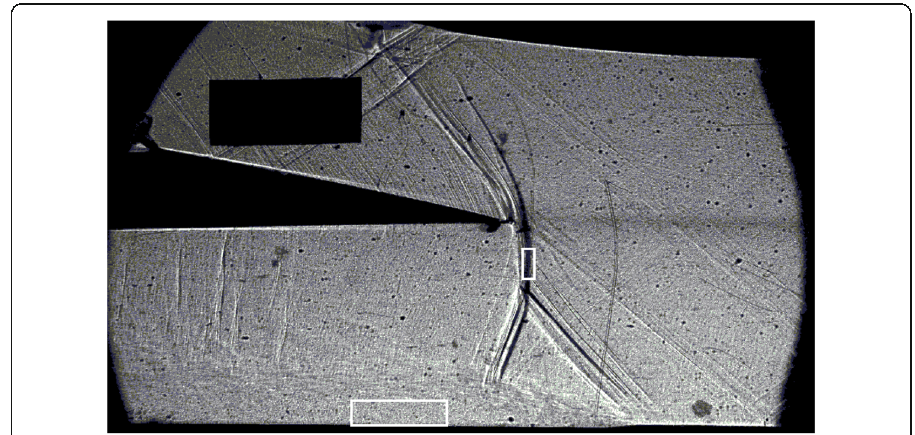
Fig. 16 Shadowgraph flow visualization image, where rectangles mark pixel locations in the downstream boundary layer and near the normal shock wave, where time-varying data are analyzed to obtain